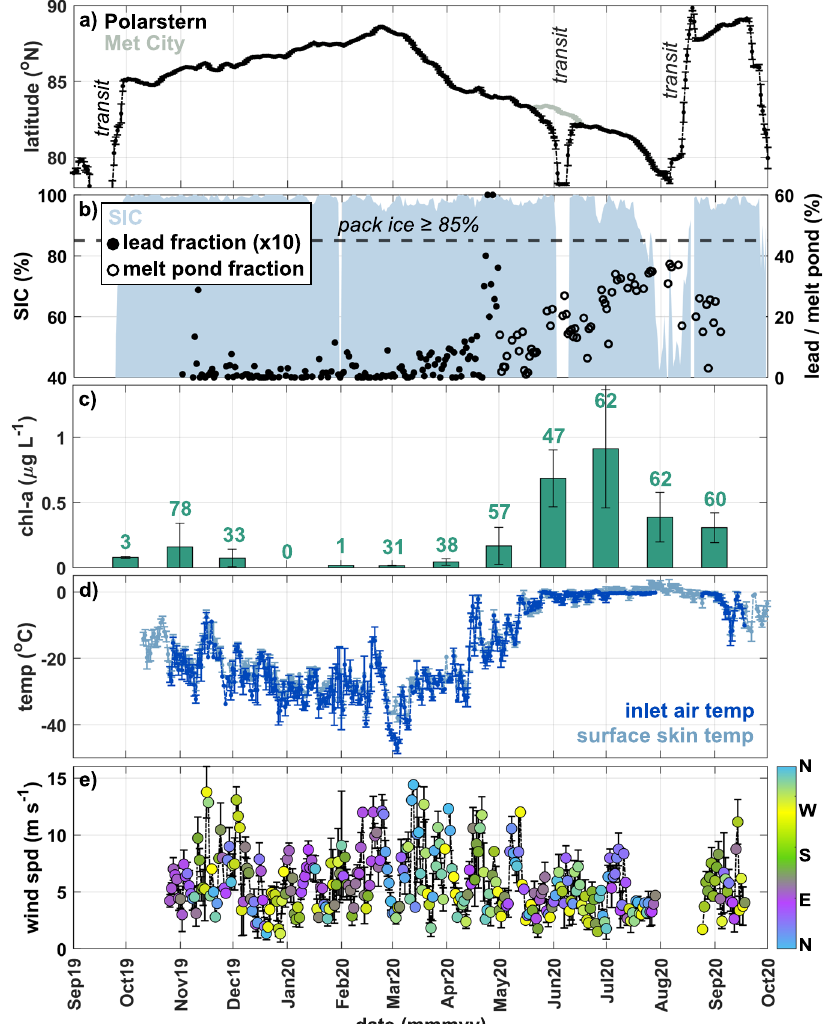
Fig. 2 Time series of fl oe location, sea ice, meteorology, and ecosystem data. a Latitude measured on Polarstern and the Central Observatory (CO) at “ Met City ” , with transit periods denoted. b Sea ice concentration (SIC), and percentage of open water in the form of leads and melt ponds within a 1 × 1 degree grid around Polarstern. Lead percentage is multiplied by 10 to show variability. c Underway chlorophyll-a (chl-a) concentration measured from samples collected on Polarstern (values = number of discrete samples). d Temperature (temp) from the aerosol inlet on Polarstern and at the ice surface, and e wind speed (wind spd) colored by direction (N north, E east, S south, and W west), from “ Met City ” . All data aside from chl-a are either collected as or averaged daily. Error bars indicate standard deviation of the